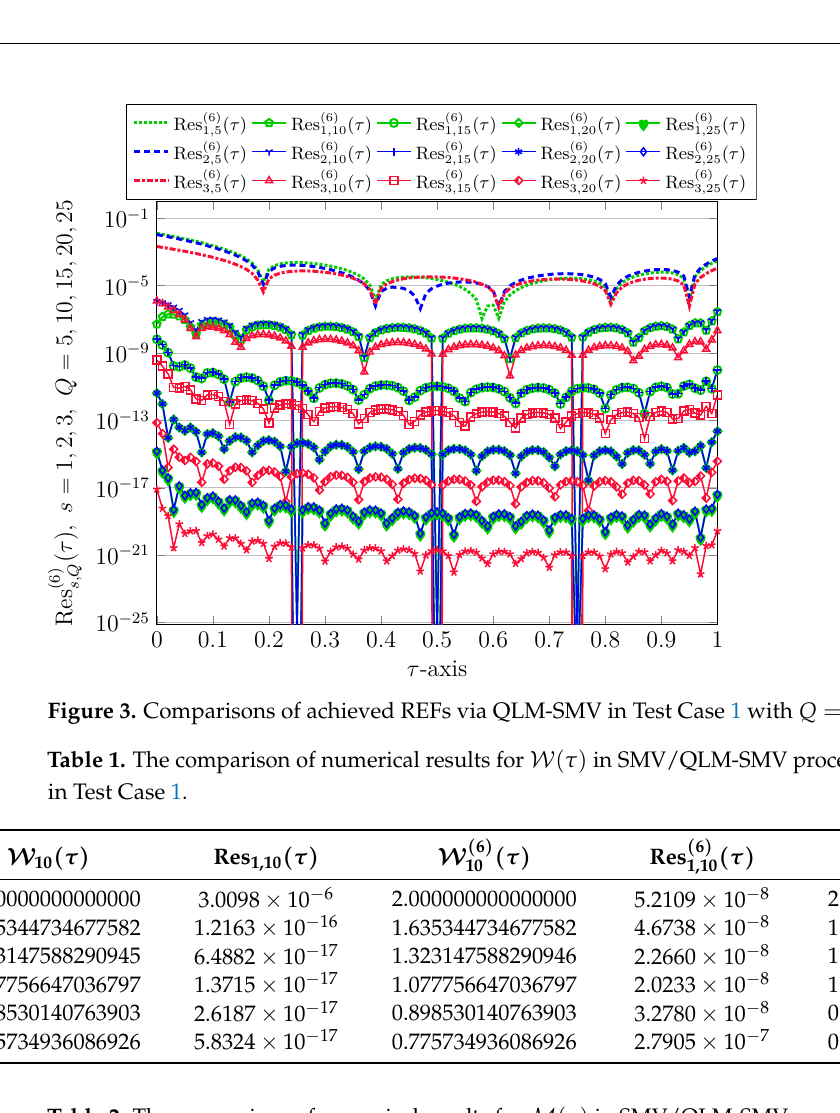
( τ ) in SMV/QLM-SMV procedure using Q = 10 M